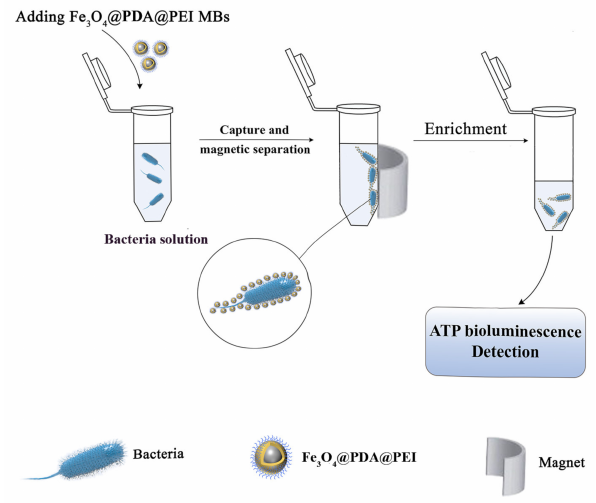
Figure 2. Schematic representation of enrichment and detection of bacteria using Fe 3 O 4 @PDA@PEI